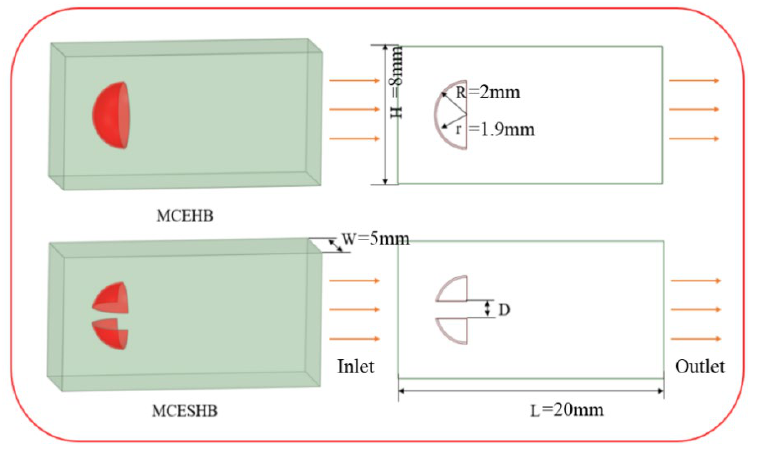
Figure 1. Physical Figure 1. Physical model.